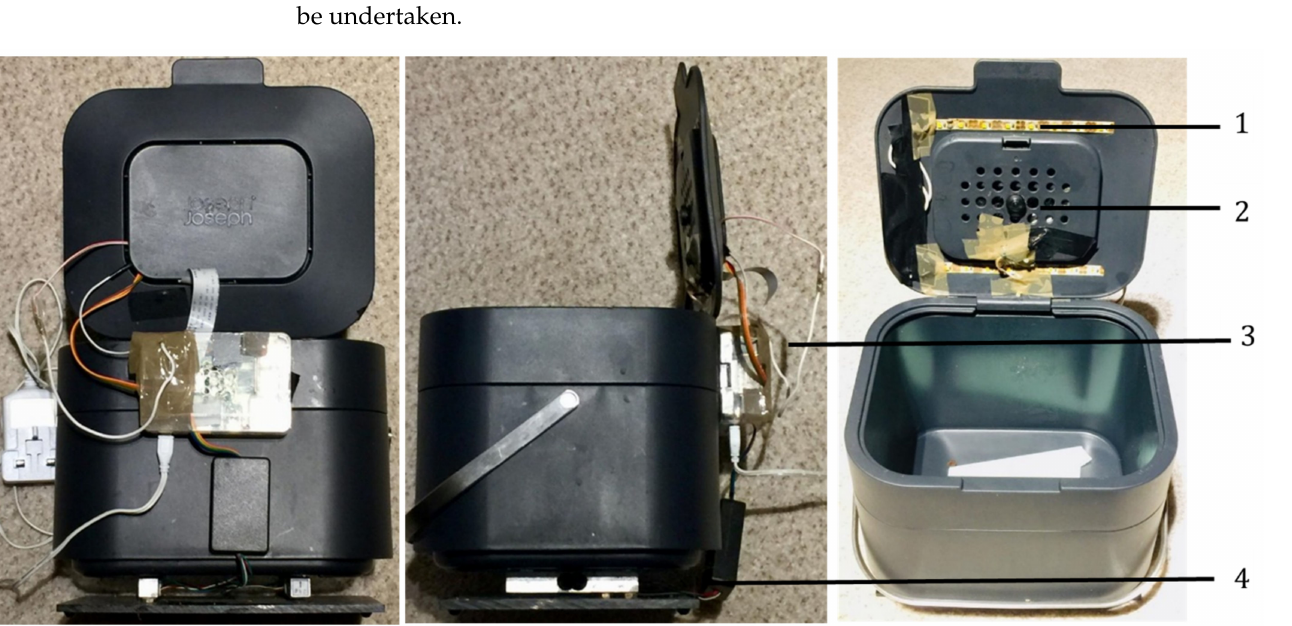
Figure 2. The smart